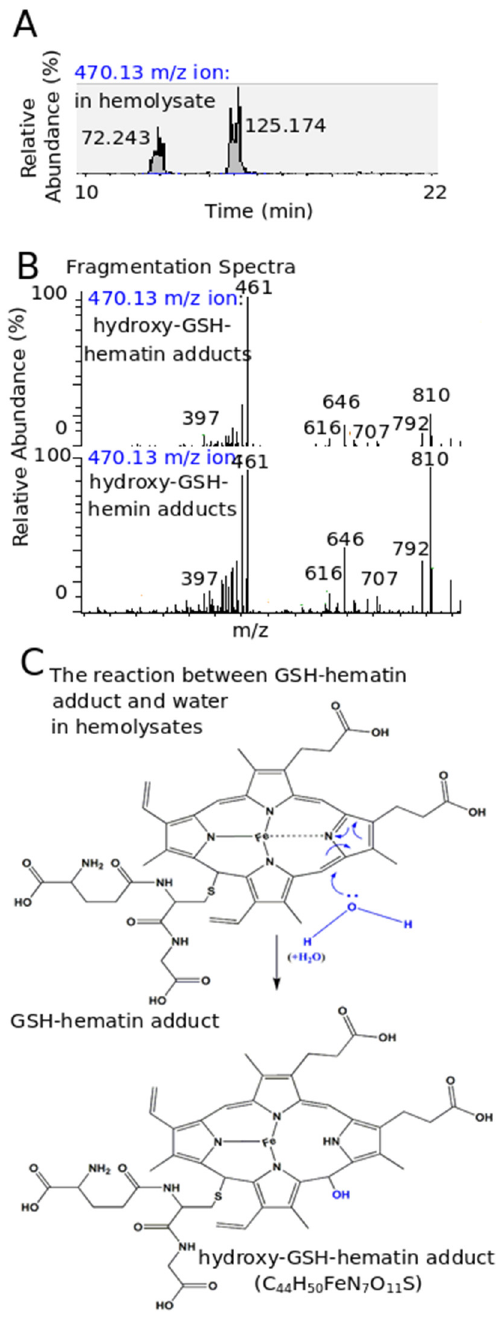
Figure 8. Identification of the 470.13 m / z ion corresponding to the hydroxy–GSH–hemin/hematin adducts in hemolysates of human RBCs. ( A ) Ion spectra of the 470.13 m / z ion, corresponding to hydroxy-GSH–hemin/hematin adducts at hemolysates (prepared as described at Figure 7A). The quantification of the ion peaks is also shown. ( B ) Paired comparison of MS2 spectra of the 470.13 m / z ion detected at the hemolysates and found in the in vitro reaction between GSH and hemin. ( C ) The mechanism of hydroxy–GSH–hematin adducts formation (one isomer is shown).